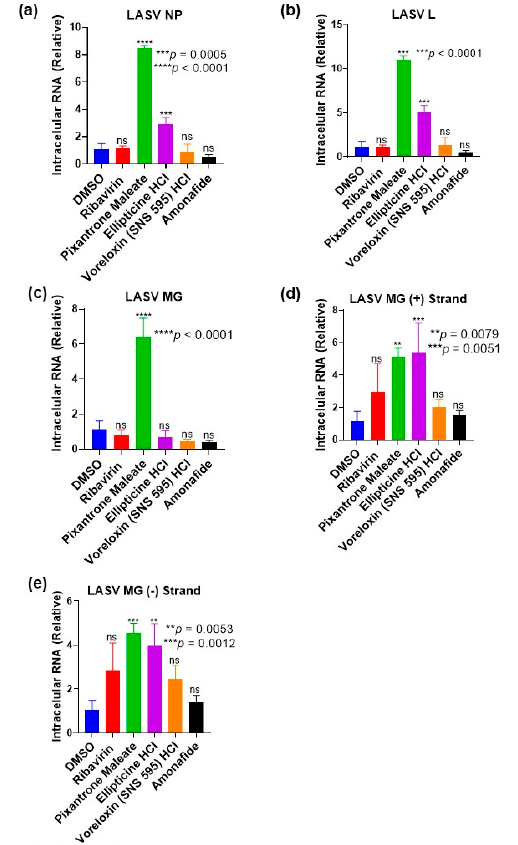
Figure 8. Topoisomerase II inhibitors do not reduce the expression of LASV MG system components. Huh-7 cells were seeded and reverse-transfected with LASV MG system plasmids on a 24-well